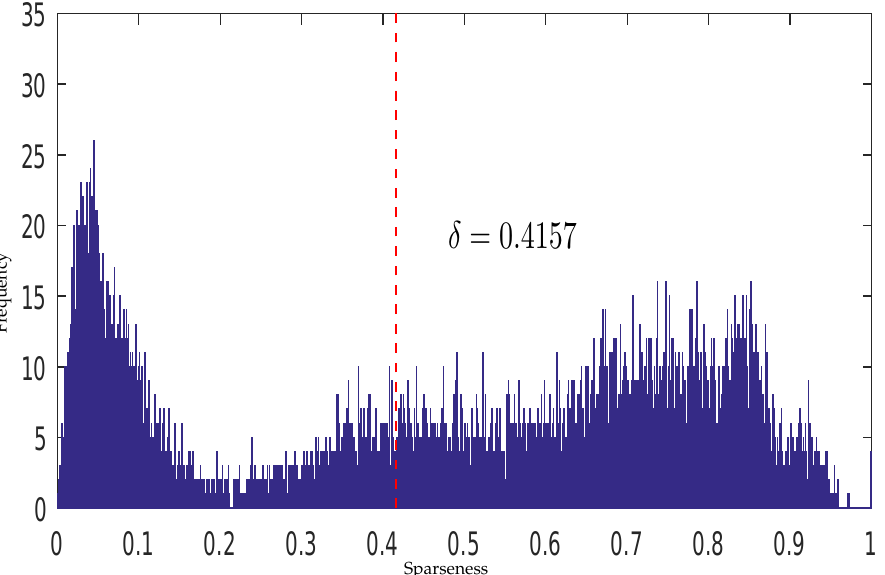
Figure 4. The histogram of estimated sparseness values for pixels in a synthetic image and the selected threshold